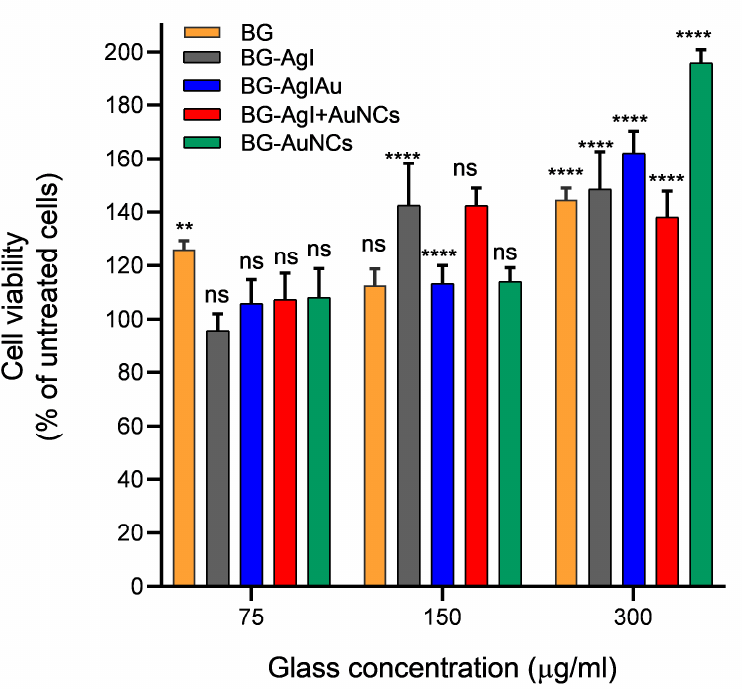
Figure 9. Viability of HaCaT cells in the presence of BG, BG-AgI, BG-AgIAu, BG-AgI+AuNCs, and BG-AuNCs in different concentrations. * p <